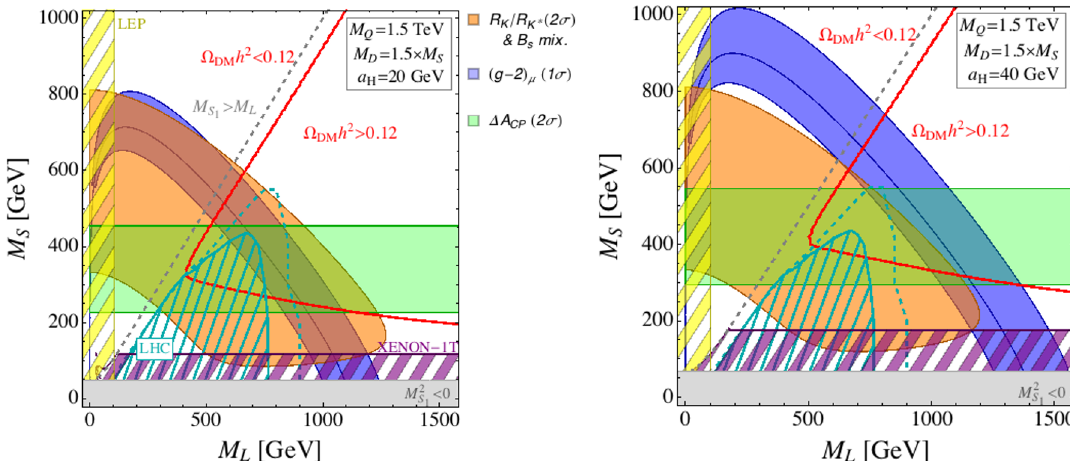
Figure 10 . Combined constraints on the vectorlike lepton mass vs the singlet mass ( M L , M S ). The doublet mass is set to M D = 1 : 5 (cid:2) M S . The coloured areas and the couplings are as in (cid:12)gure 9. Cf. the main text for further